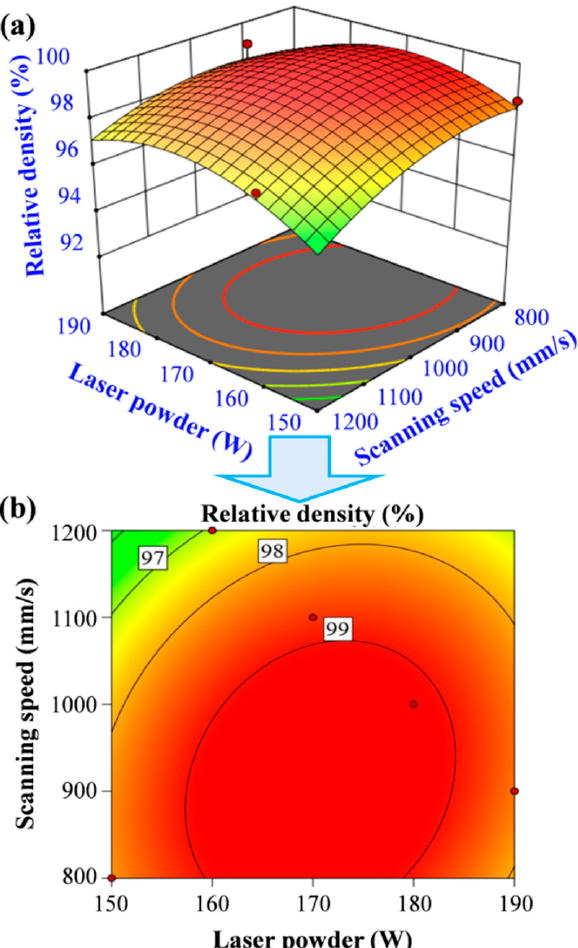
Figure 2. Response surface graph ( a ) and contour plot ( b ) of the effects of laser power and scanning speed on the relative density at scanning interval 0.06 mm.